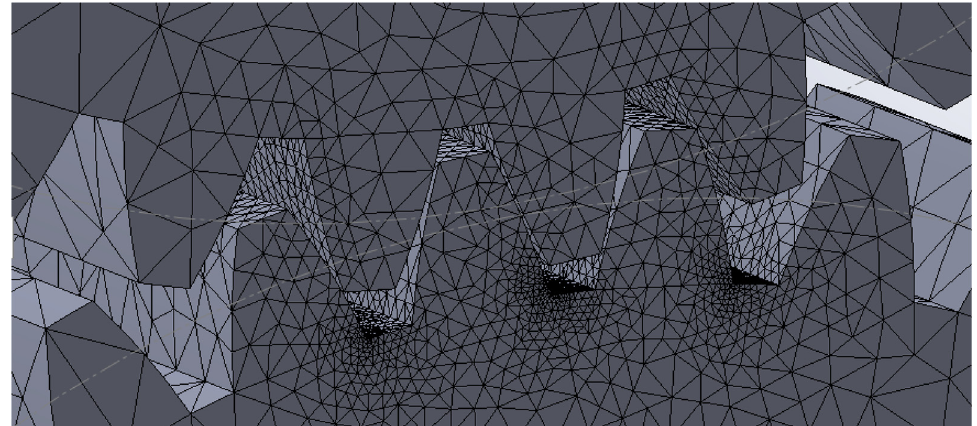
Fig. 7. Regions of local meshing of a 40/40 pair of gears.